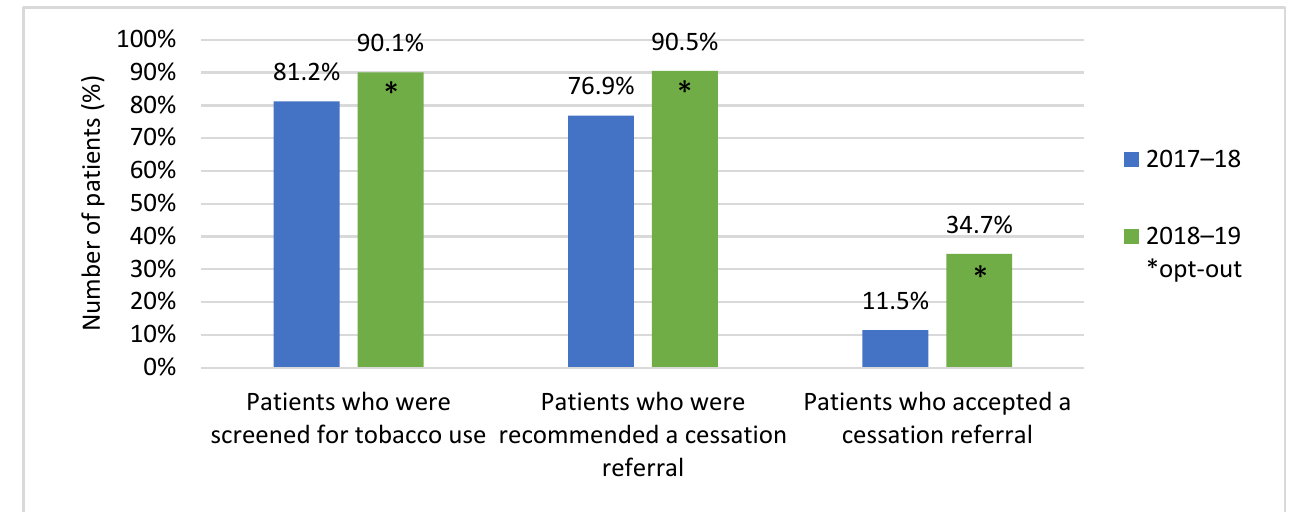
Figure 1. A comparison of the percentage of patients screened for tobacco use, the percentage of patients offered a referral to a quit smoking service, and the percentage of patients who accepted an offered referral in 2017/2018 and 2018/2019, respectively.